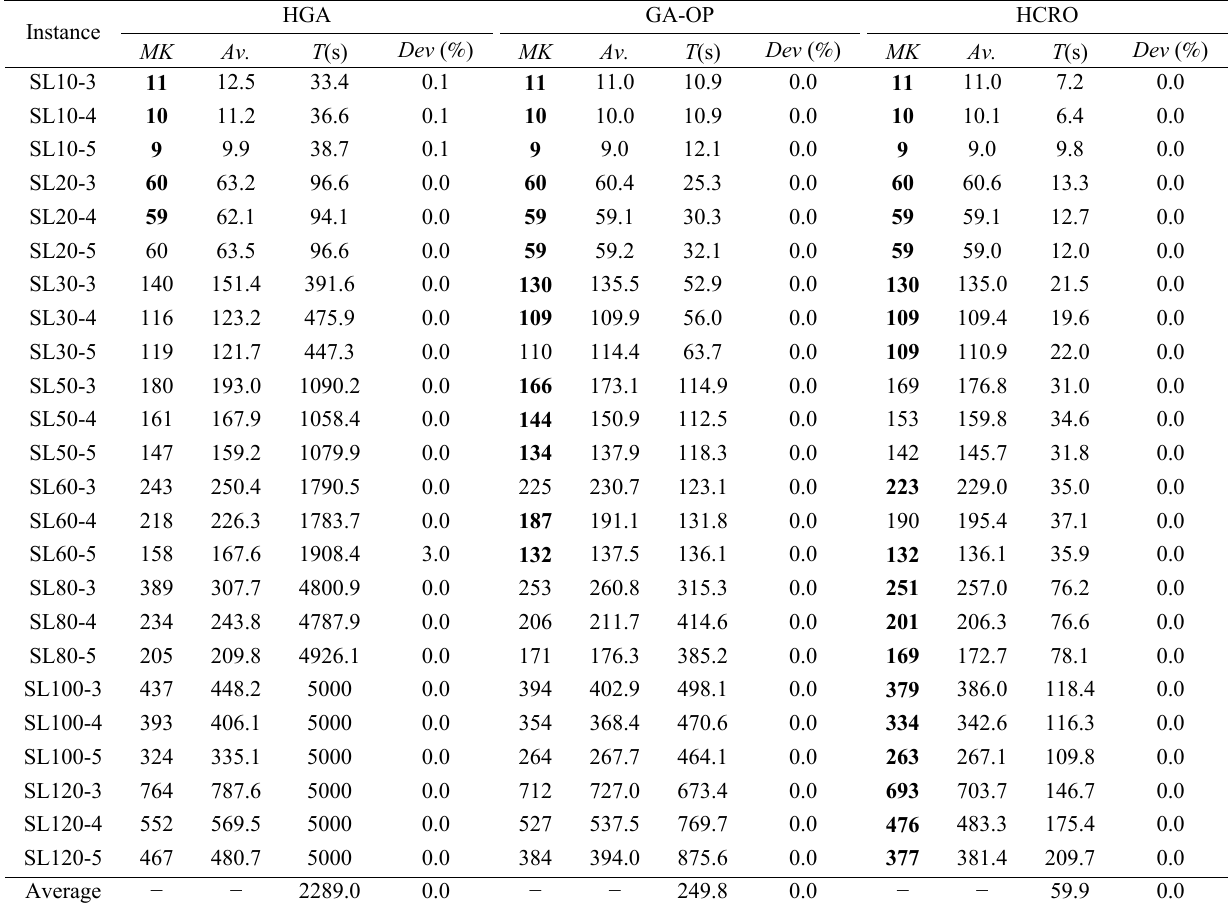
Table 11 Performance comparison between different algorithms in heterogeneous FMUs in Experiment 3. HGA GA-OP HCRO Instance